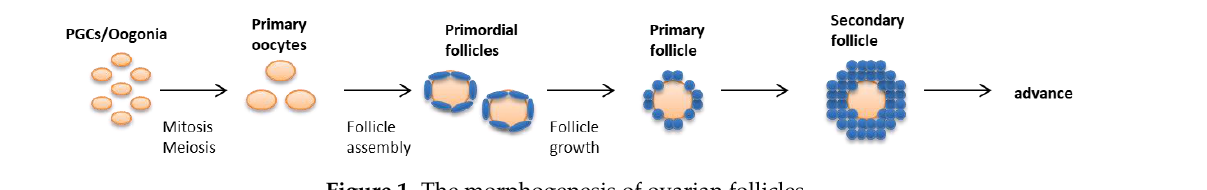
Figure 1. The morphogenesis of ovarian follicles. Table 1. Follicular development process and related